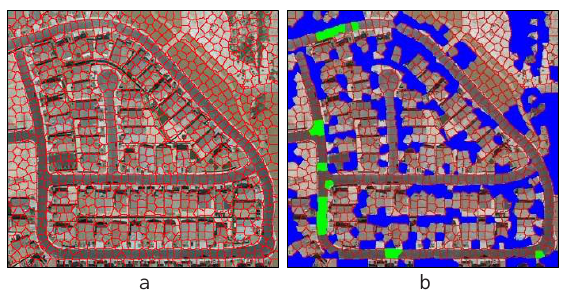
Figure 4. Markers refinement. a) Super-pixel segmentation result; b) Refined